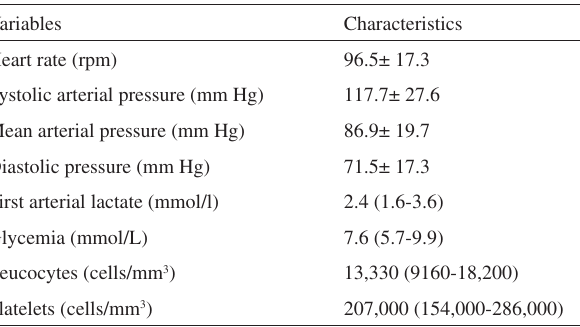
Table 2 - Main physiologic and laboratory variables at in-